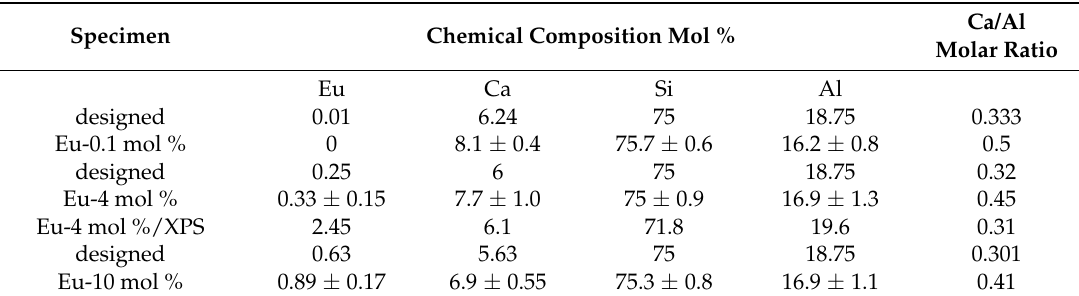
Table 2. Chemical composition by EDS of the chosen phosphor powders and XPS results for specimen Eu-4 mol